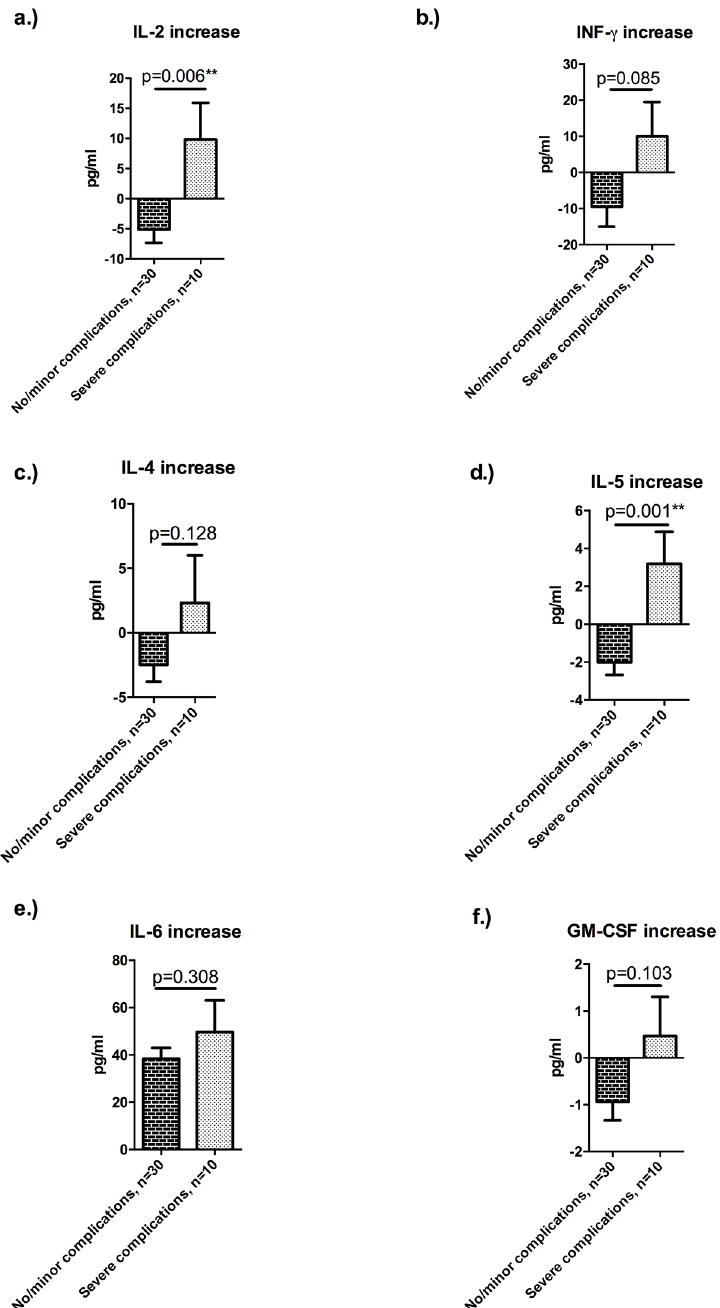
Fig 4. Inflammatory response during and after liver resection. (A) Mean interleukin-2(IL-2) increase duringsurgery was more pronouncedin patients, who developedsevere postoperative complication (-5.1 (2.2) pg/ml vs. 9.8 (6.1) pg/ml; p = 0.006). (B) Similar to that, there was a trend towards an increased interferon-gamma (INF-y) response(p = 0.085). (C, D) Whereas there was only a trend towards a higherIL-4 increaseduringliver resection, an higherinterleukin-5(IL-5) increaseduringhepatectomy was predictive for severe postoperative complication(-2 (0.7) pg/ml vs. 3.2 (1.7) pg/ml; p = 0.001). (E) There was no significant difference regardingperioperative IL-6 increase. (F) Perioperative increase in granulocyte macrophage colony-stimulating factor (GM-CSF) was higherin patients with major complication comparedto